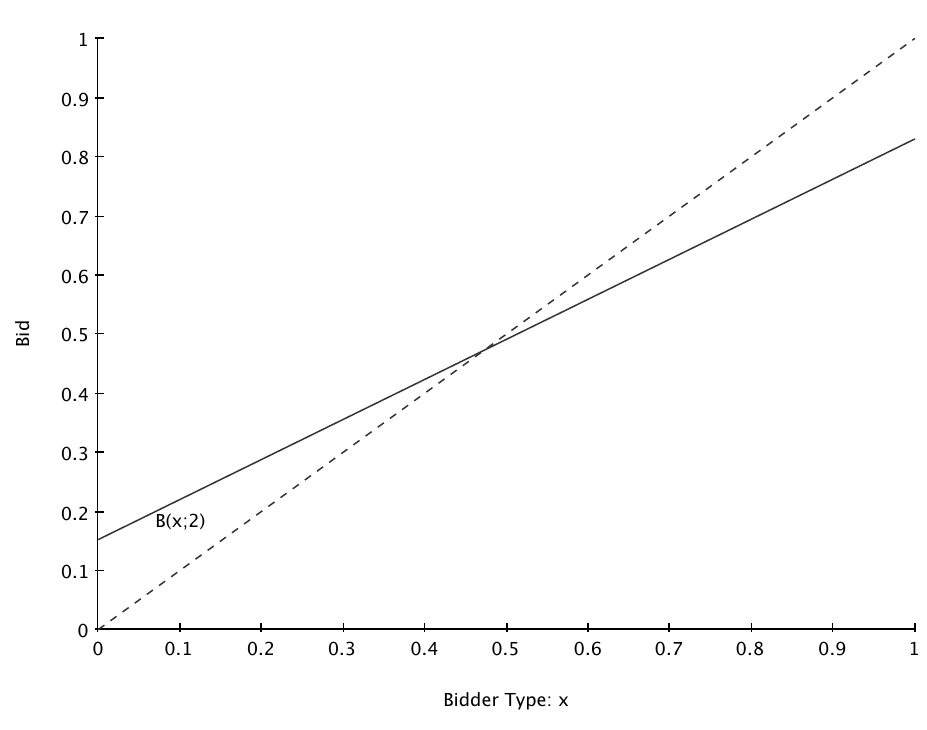
Figure 1. Equilibrium Bidding Strategy for u(0,1) and N = 2